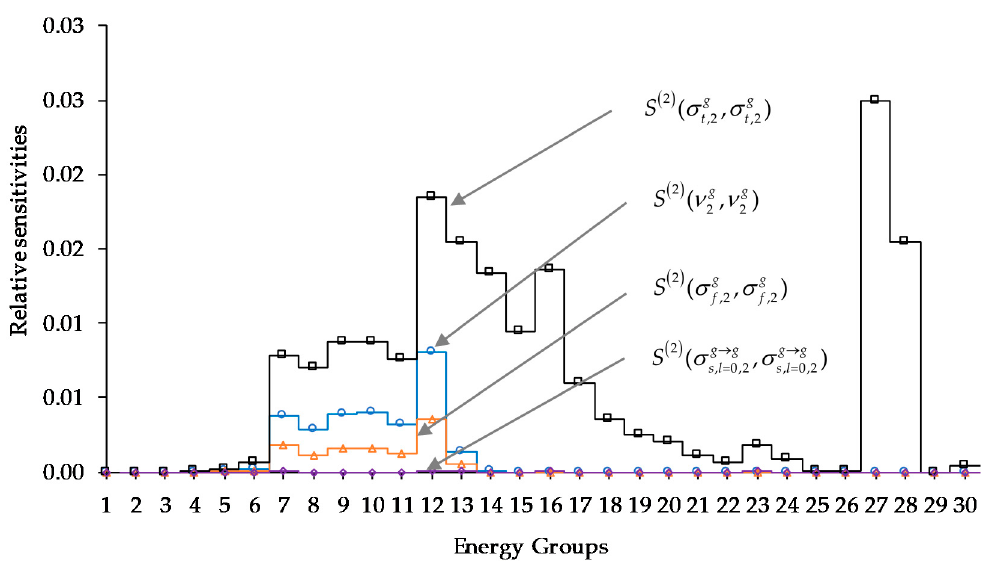
Figure 5. Comparison of second-order relative sensitivities for isotope 2 ( 240 Pu).